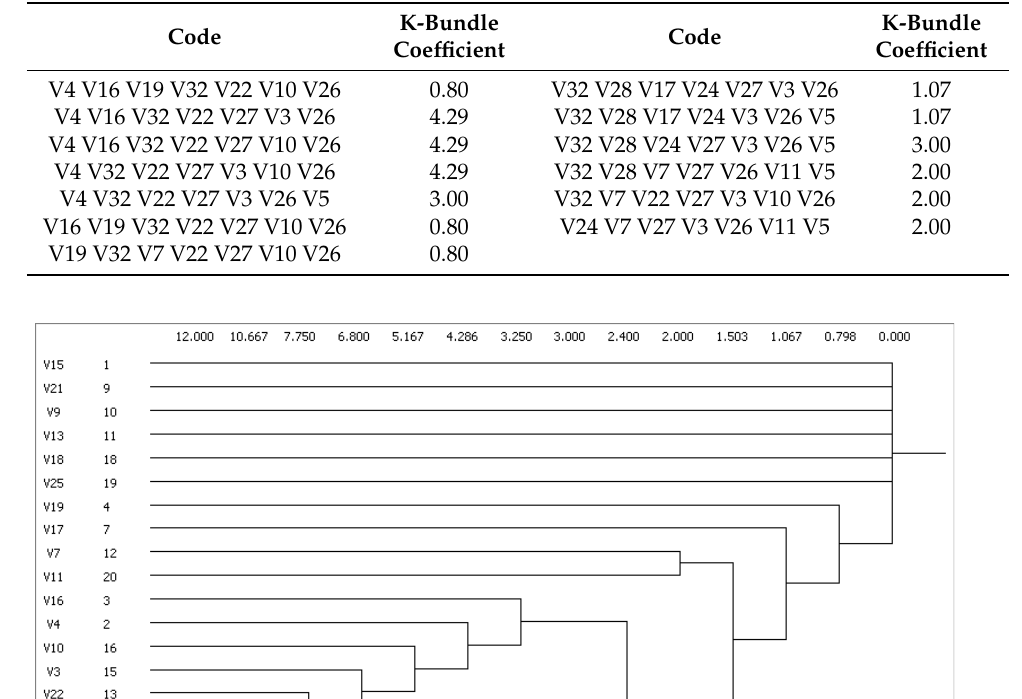
Table 7. K-cluster analysis of the network. Figure 7. Factional analysis tree of the network.